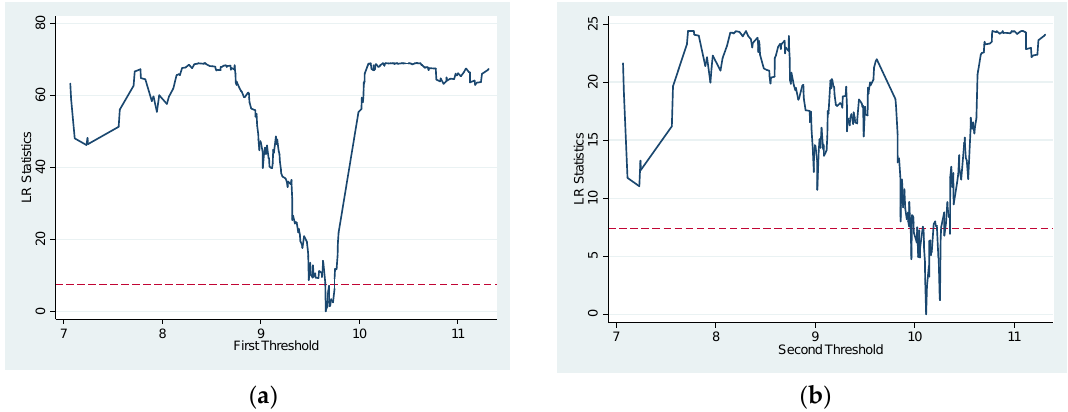
Figure 3. Threshold estimator and confidence interval of financial development. ( a ) The LR function diagram of the first threshold value; ( b ) The LR function diagram of the second threshold value.